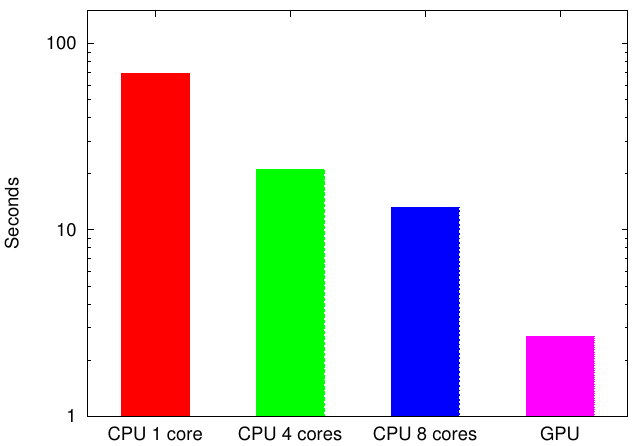
Figure 12. Reconstruction times and speed-up using CPU, multi-core CPU and